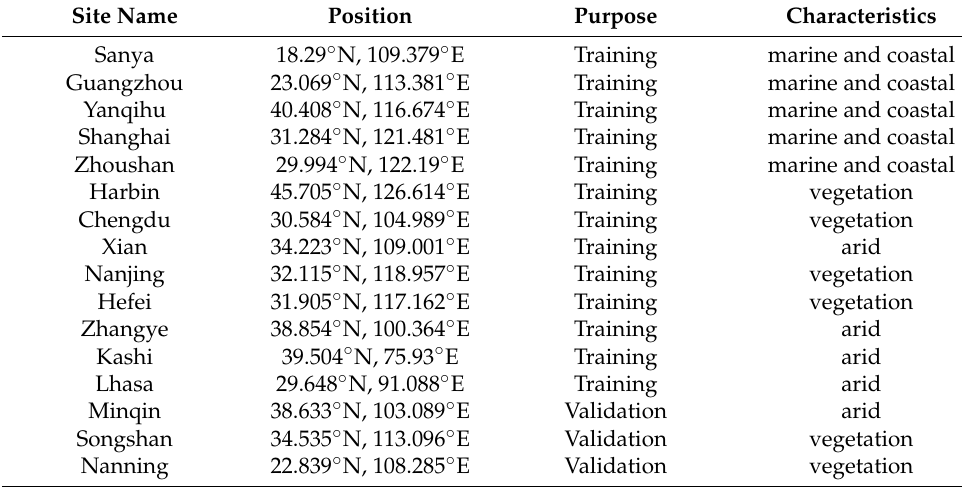
Table 3. SONET sites used to train and verify the NNAeroG.